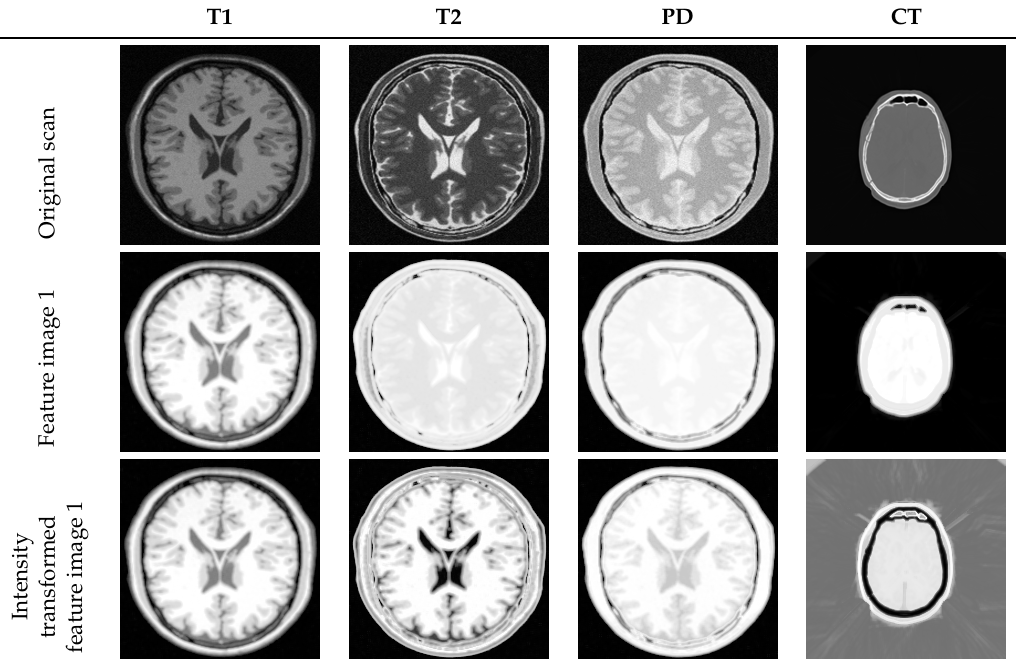
Figure 9. Intensity transformation of multi-modal medical scans. ( Top row ) shows the original MRI and CT scans of the human brain; ( Middle row ) shows the first feature image of each modality after manifold learning; ( Bottom row ) shows the same feature images after manifold alignment. Intensity mapping of feature images obtained from T2-, PD-MRI, and CT are matched with the one obtained from